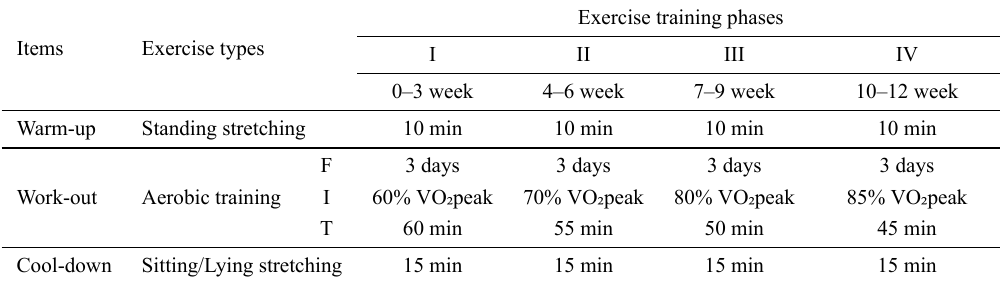
Table 3. Treadmill exercise training program.